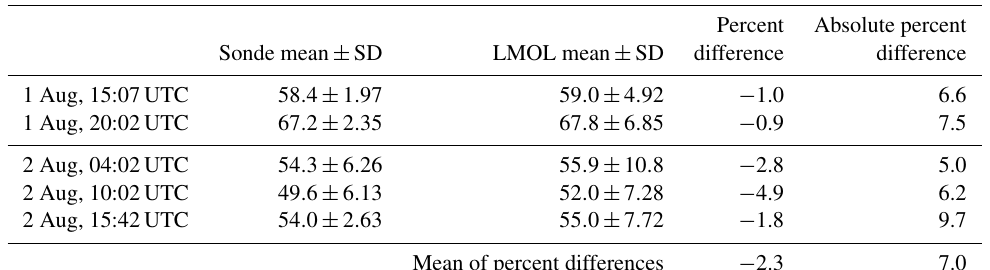
Figure 4. Ozonesonde and LMOL comparison for near field (0–1000m) and the percent height differences for all flights displayed on the bottom-right plot. Table 1. Comparison of ozonesonde and LMOL column (0 to 1km) average ozone values (ppbv), the percent differences (bias), and the absolute differences for Fig. 4 flights. The data sample standard deviations are also shown along with the mean